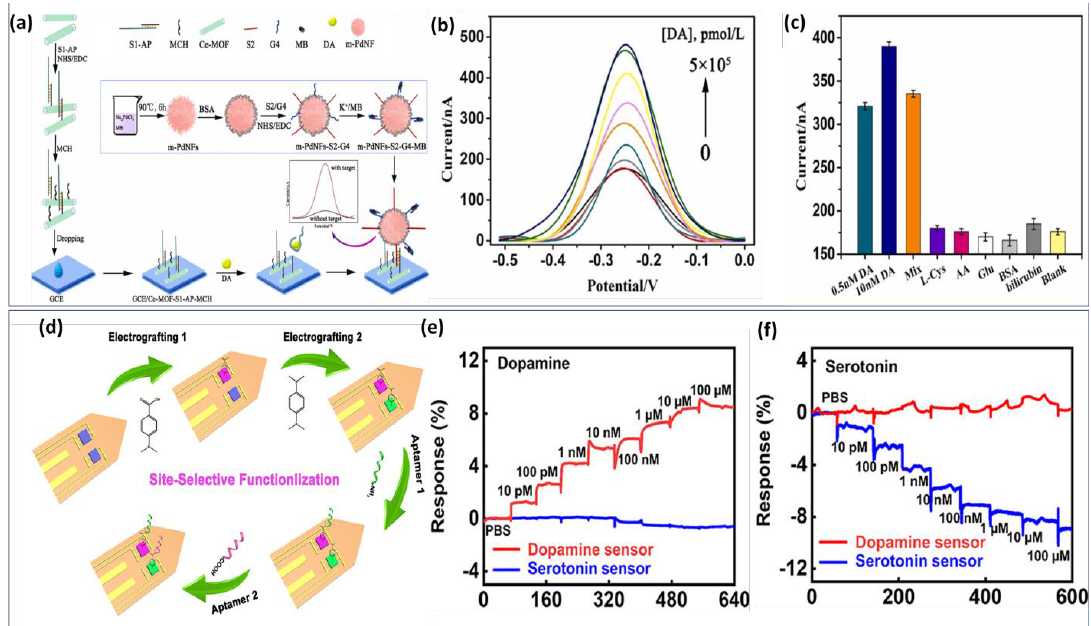
Figure 5. Assembly process of electrochemical aptasensor fabrication: ( a ) Methylene blue − integrated Ce − MOF capturing DNA for specific DA monitoring in human serum. ( b ) SWV curves of different concentrations of dopamine up to 100 nM. ( c ) Specificity study of the proposed aptasensor. Reproduced with permission from [133]. Copyright 2023, Elsevier, ( d ) Electrografting process of DNA − Aptamer-based multi-probe for simultaneous detection of DA and Serotonin in ex vivo. ( e ) Real-time response of dopamine and ( f ) serotonin with a concentration range from 10 pM to 100 μM . Reproduced with permission from [134]. Copyright 2022, ACS.